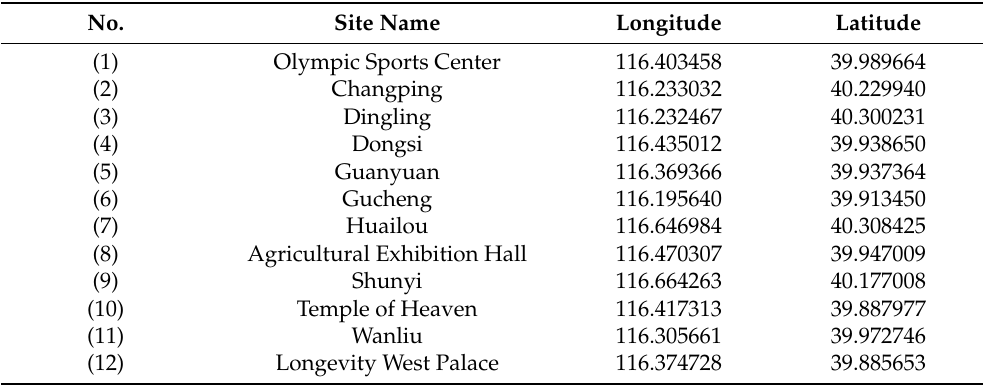
Table 1. Station longitude and latitude